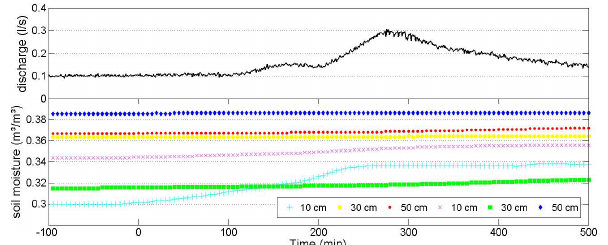
Fig. 4. Discharge and soil moisture dynamic during the second ex- periment, two theta probes for soil depths of 10cm, 30cm, and 50cm, with a lateral distance of approximately